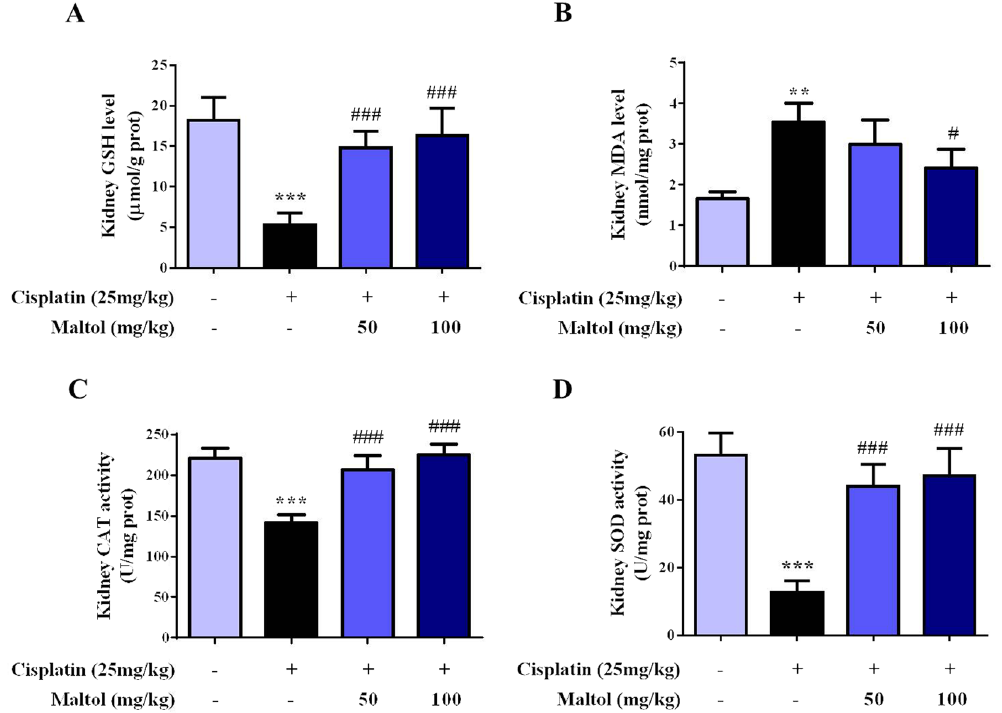
Figure 1. Protective effects of maltol pretreatment against cisplatin-evoked renal toxicity in mice. After cisplatin challenge, all mice were euthanized and their serums and kidneys were collected. ( A ) Kidney GSH level. ( B ) Kidney MDA level. ( C ) Kidney CAT level. ( D ) Kidney SOD level. All values were expressed as mean ± S.D. ( n = 8 in each group). ** p < 0.01, *** p < 0.001 vs . normal group; # p < 0.05, ### p < 0.001 vs . cisplatin